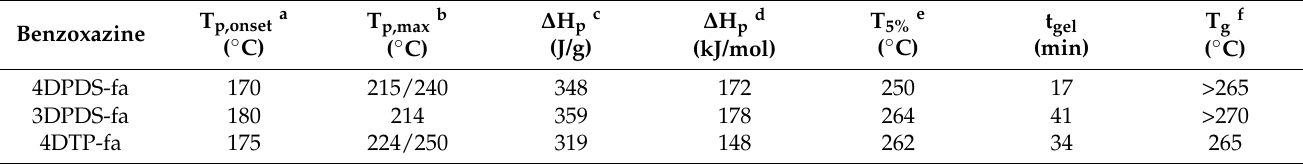
Table 2. Thermal and thermo-mechanical properties of 4DPDS-fa, 3DPDS-fa, and 4DTP-fa, and their corresponding